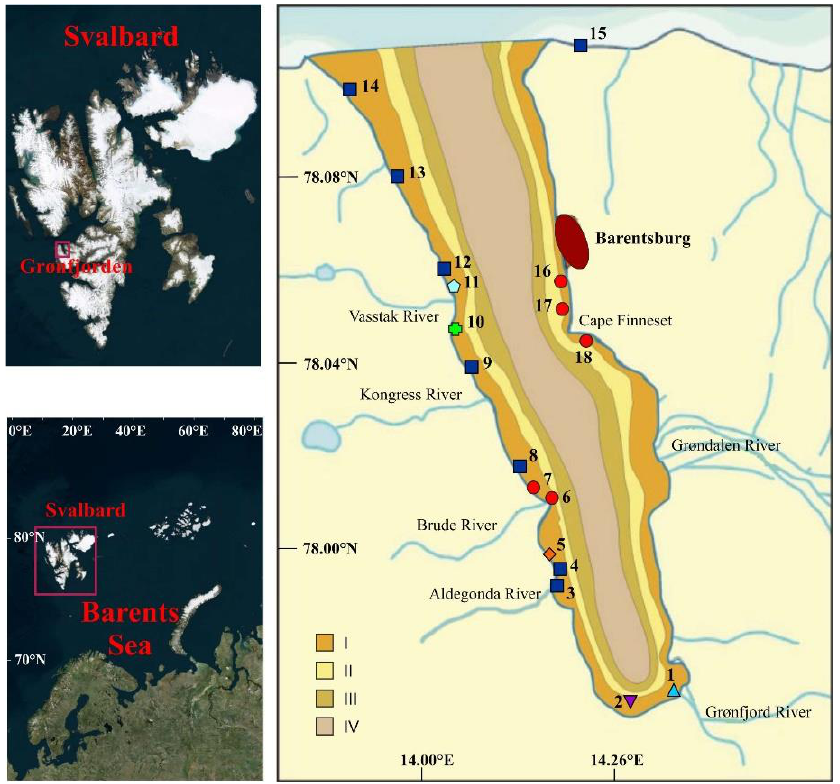
Figure 1. Location of sampling stations and sediment composition in Grønfjorden, West Spitsbergen. Sediments: I — Gravel, pebble, and boulders; II — sand; III — silt; IV — clay [52]. Groups of stations based on bryozoan biomass: red — Cluster 1, blue — Cluster 2, other colors — outliers.